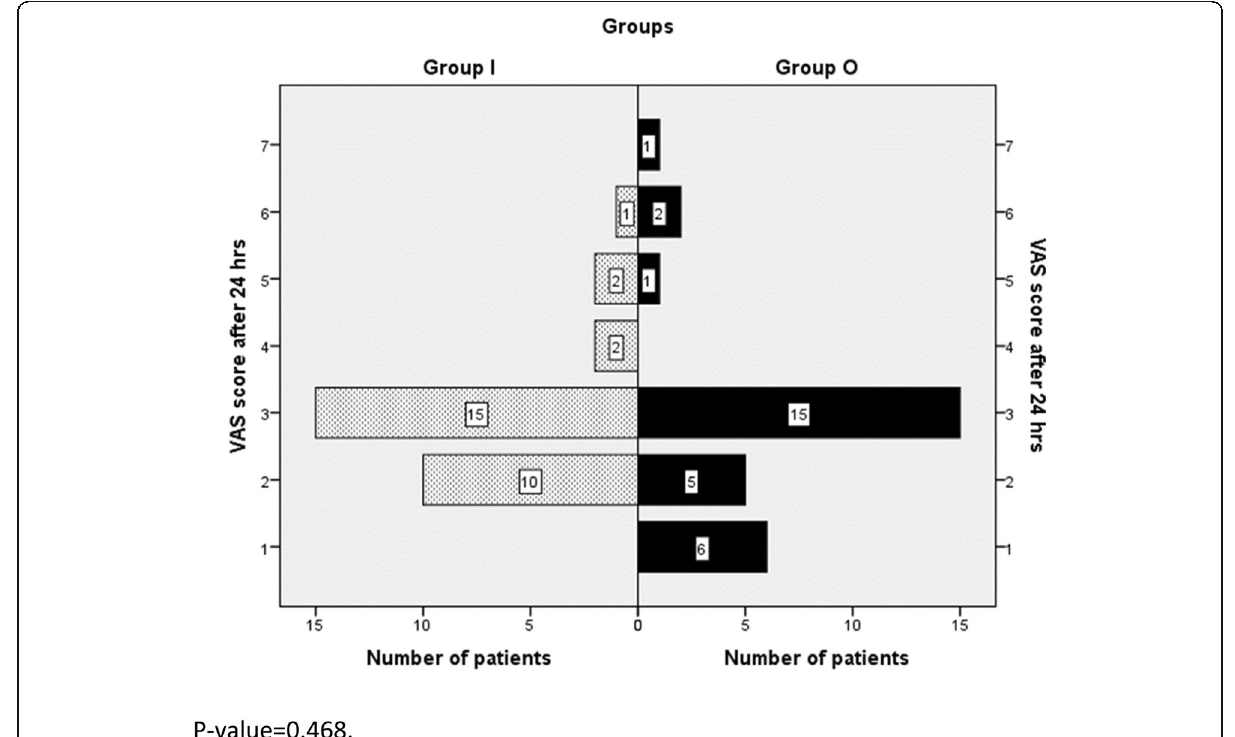
Fig. 2 The distribution of the VAS score at 24 postoperative hours . P value =